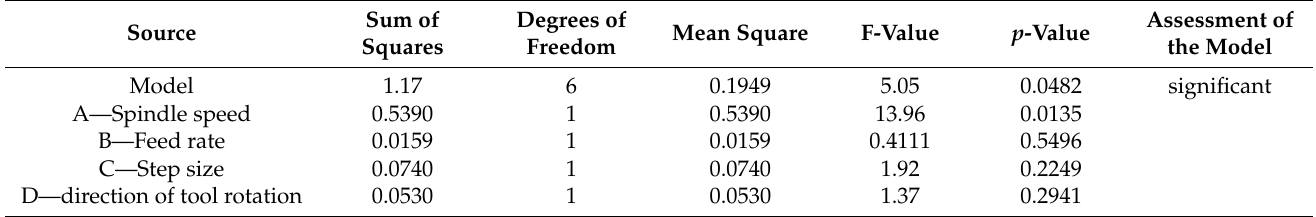
Table A4. ANOVA results of the Sa parameter measured on the outer side of the